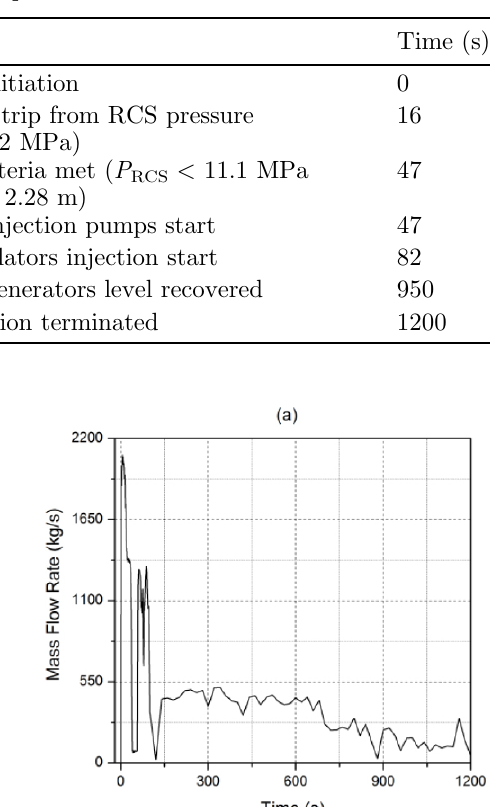
Table 4. Sequence of events in the accident evolution.